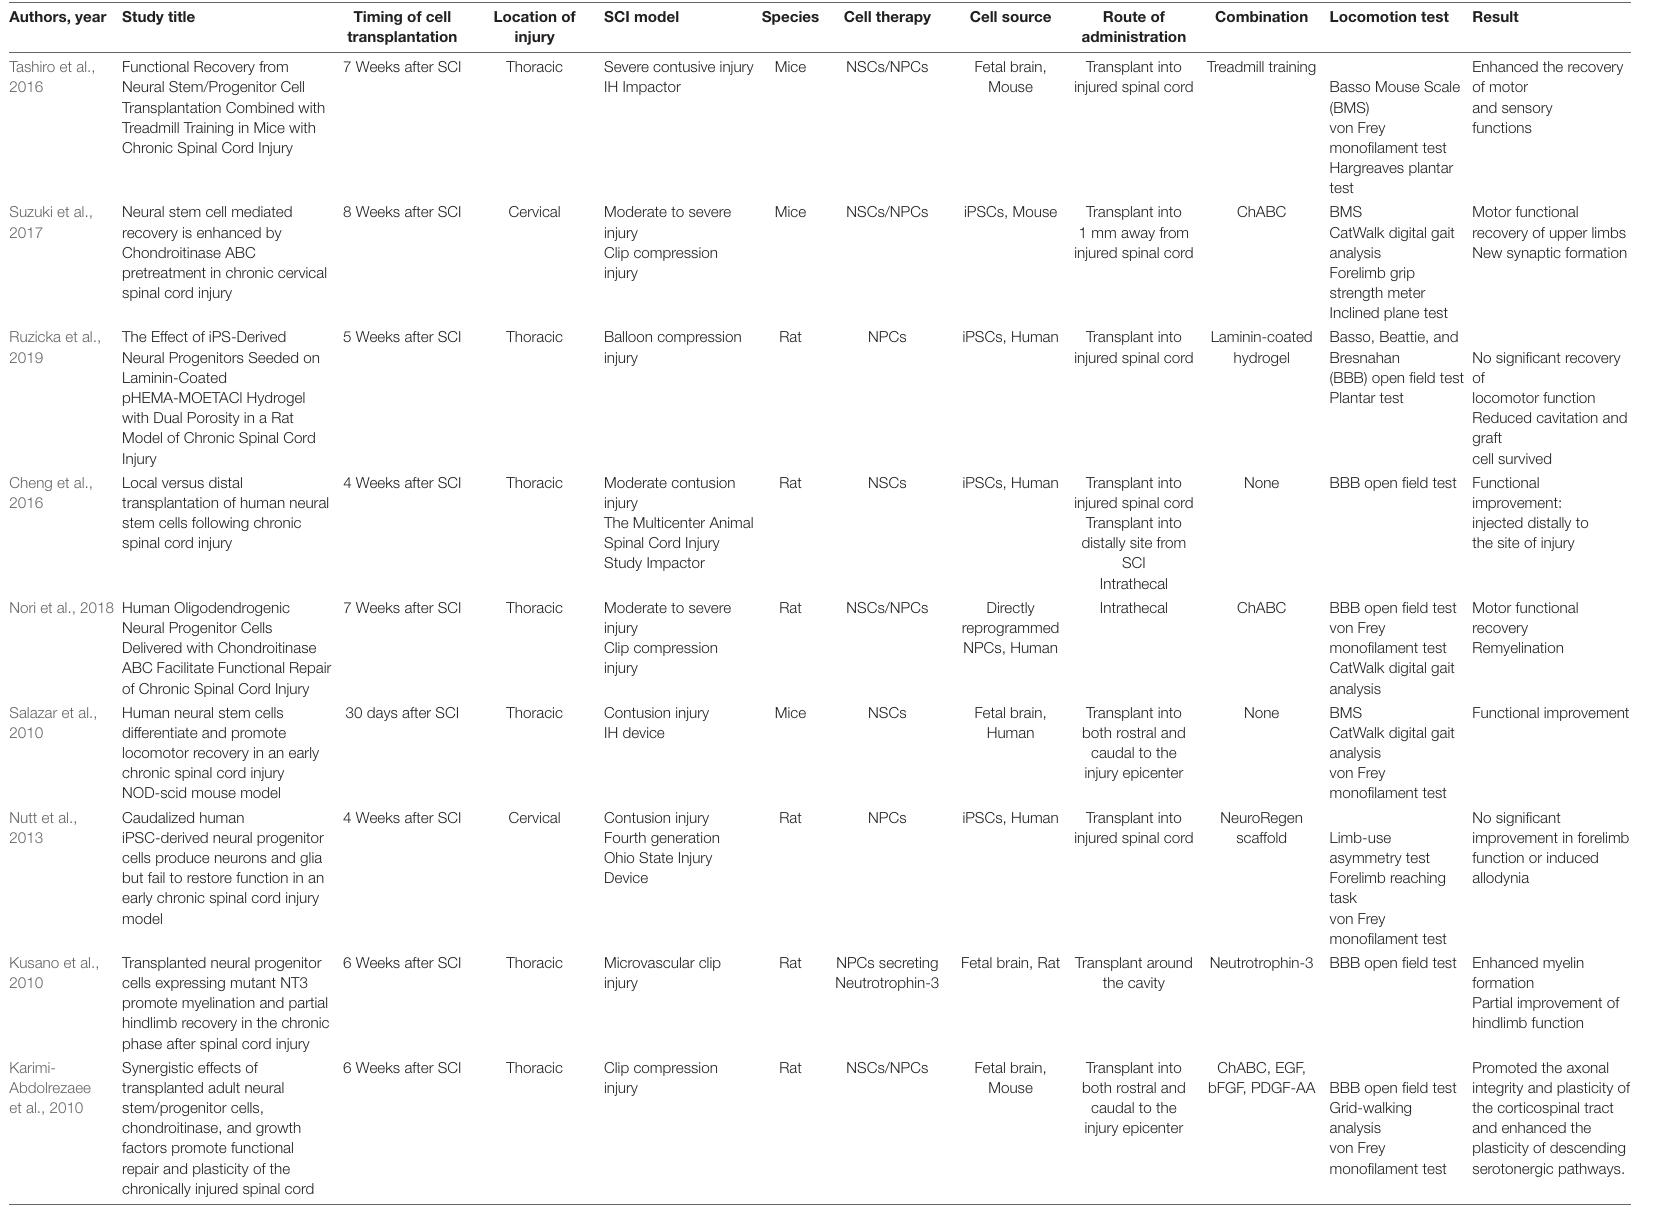
TABLE 2 | Characteristics of included experimental studies for chronic